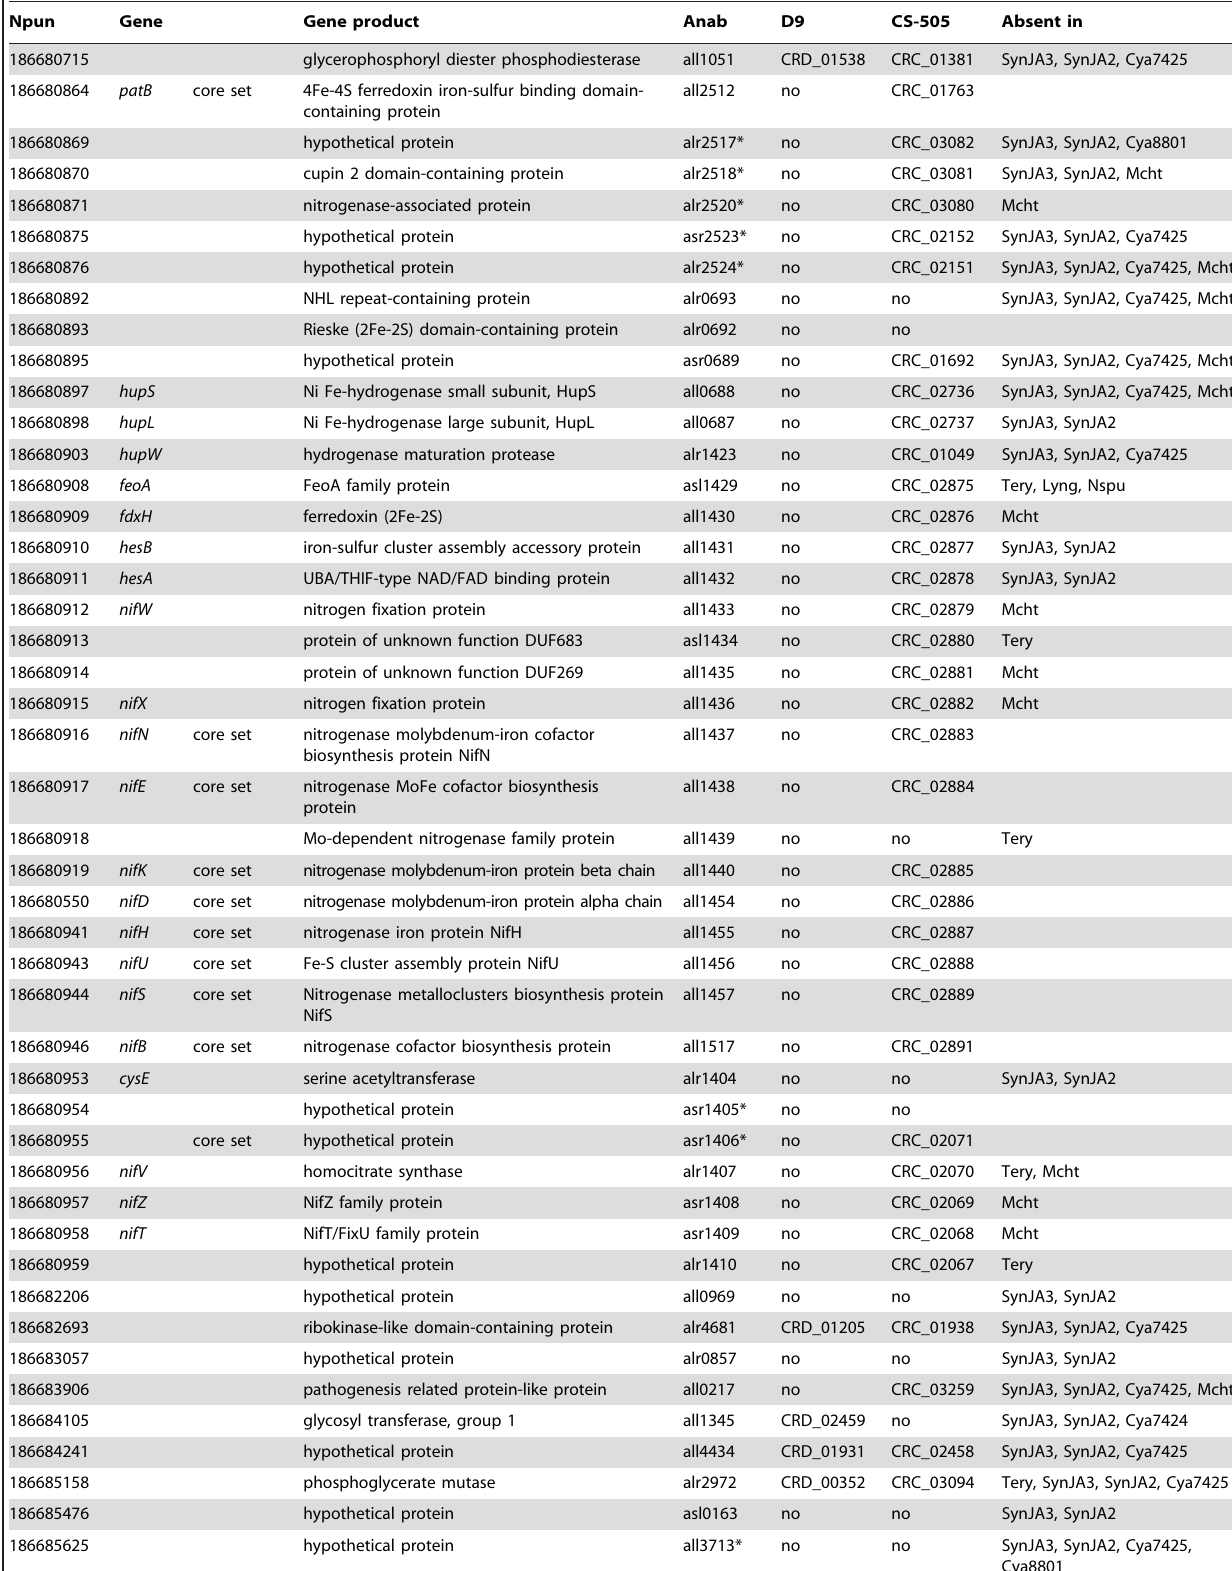
Table 5. Genes present in N 2- fixing